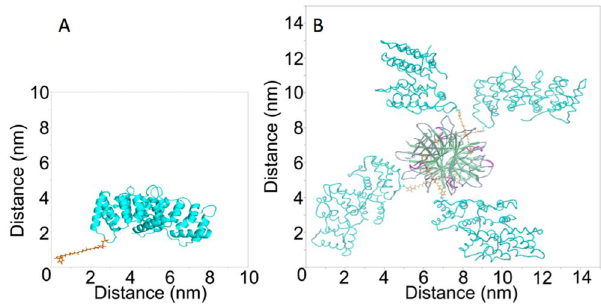
Figure 2. Three-dimensional (3-D) models of anxA5-Biotin (A) and anxA5-NP (B). The 3-D structure was retrieved from the 1ANX entry of the Protein Data Bank (PDB). Residue 166 was replaced by a cysteine and coupled to maleimide-PEG2-Biotin using Yasara. The picture was generated using PyMOL. The structure of streptavidin was retrieved from the 1SWG entry of PDB. 4 anxA5-biotin monomers were docked to streptavidin’s biotin binding pockets and the picture was generated using ICM-Pro.